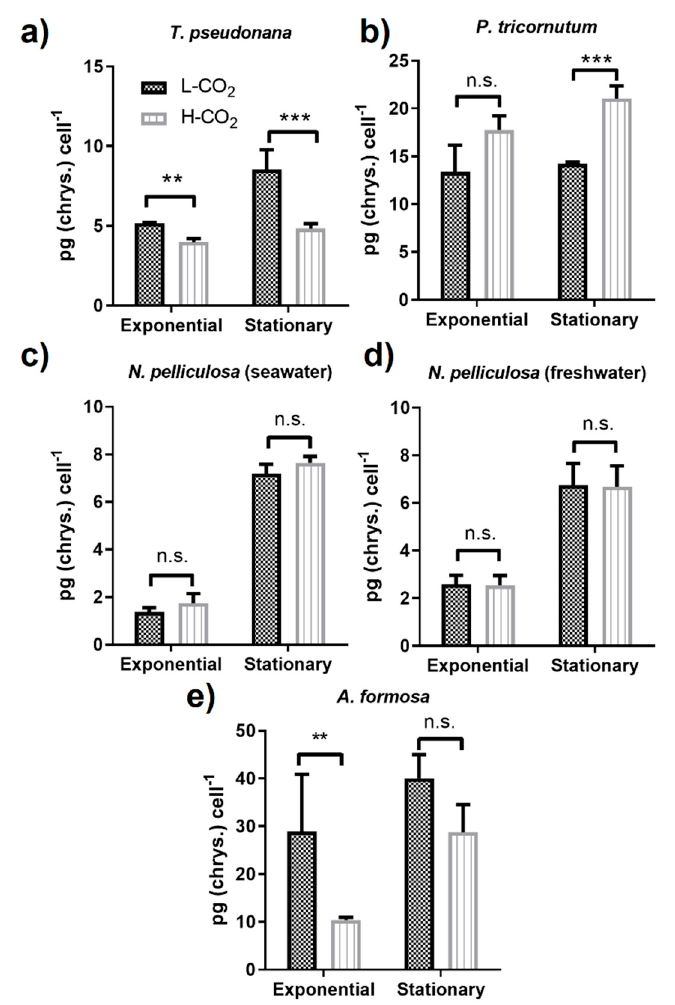
Figure 3. Production of chrysolaminarin in diatoms ( a – e ) at different CO 2 concentrations. All panels represent low CO 2 (L-CO 2 ; 400 ppm, dark grey bars) and high CO 2 (H-CO 2 ; 20,000 ppm, light grey and dashed bars) as in panel ( a ). Average and error bars (SD) are represented ( n = 3). ** p ≤ 0.01, *** p ≤ 0.005, and ns, not significant.